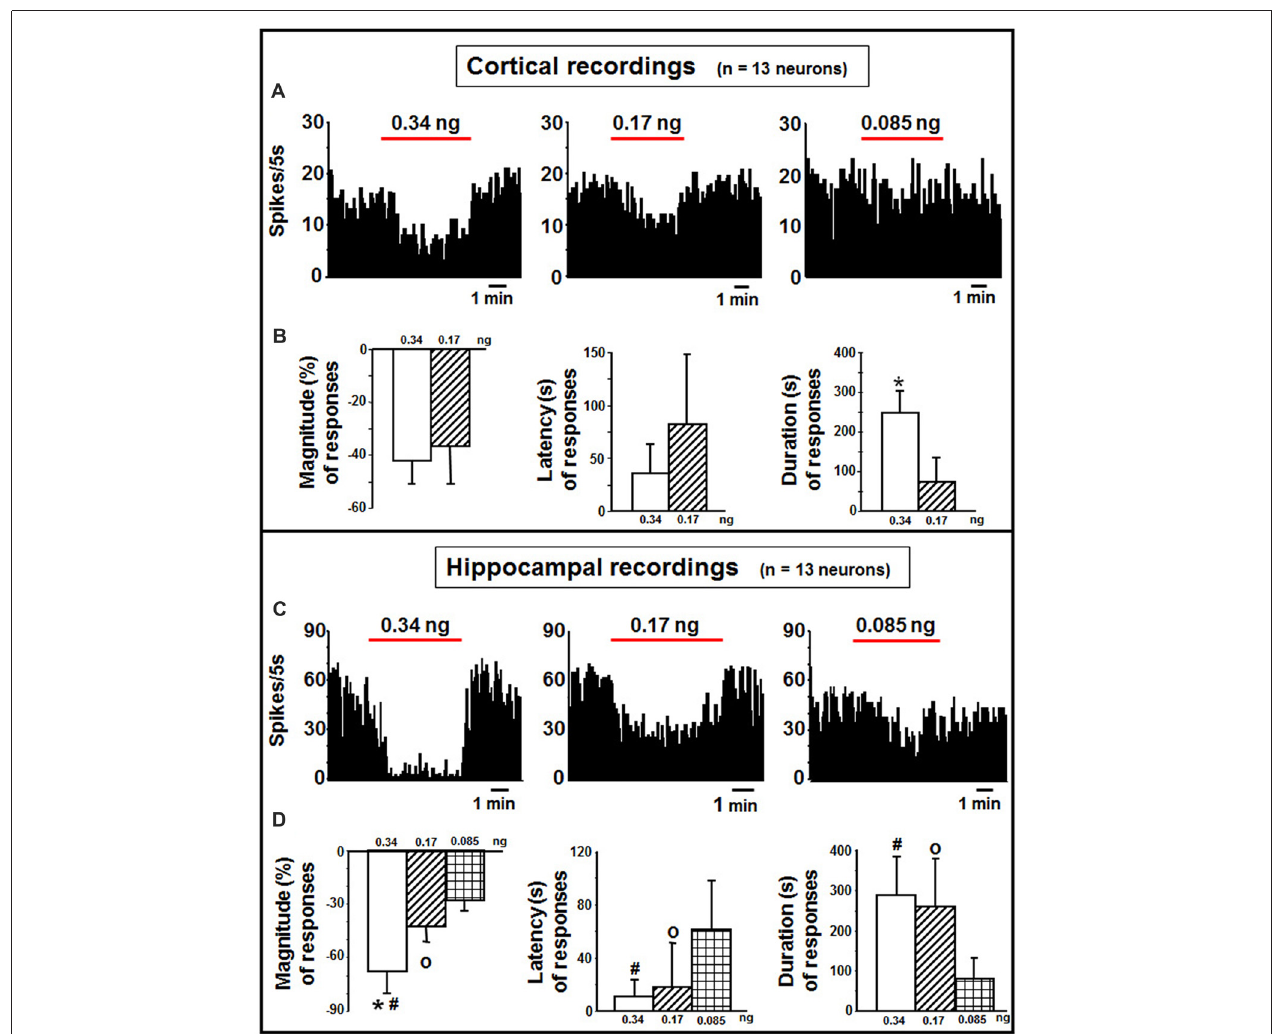
FIGURE 3 | Cortical and hippocampal recordings. (A) Representative rate-meter histogram (bin width 5 s) showing the firing rate of a cortical neuron following indicaxanthin administration at various amounts (0.34, 0.17, 0.085 ng/neuron) for 5 min. (B) Bar histogram for magnitude, latency and duration showing the significant effect of indicaxanthin at different amounts (0.34, 0.17 ng/neuron) on cortical neuronal responses ( n = 13). Each bar represents mean values ( ± standard deviation; ∗ statistically significant effect of indicaxanthin 0.34 vs. 0.17 ng/neuron). (Statistical significance for P < 0.05). (C) Representative rate-meter histogram (bin width 5 s) showing the firing rate of a hippocampal neuron following indicaxanthin administration at various amounts (0.34, 0.17, 0.085 ng/neuron) for 5 min. (D) Bar histogram for magnitude, latency and duration showing the significant effect of indicaxanthin at different amounts (0.34, 0.17, 0.085 ng/neuron on hippocampal neuronal responses ( n = 13). Each bar represents mean values ( ± standard deviation; ∗ statistically significant effect of indicaxanthin 0.34 vs. 0.17 ng/neuron; # statistically significant effect of indicaxanthin 0.34 vs. 0.085 ng/neuron; ◦ statistically significant effect of 0.17 vs. 0.085 ng/neuron). Statistical significance for P < 0.05.